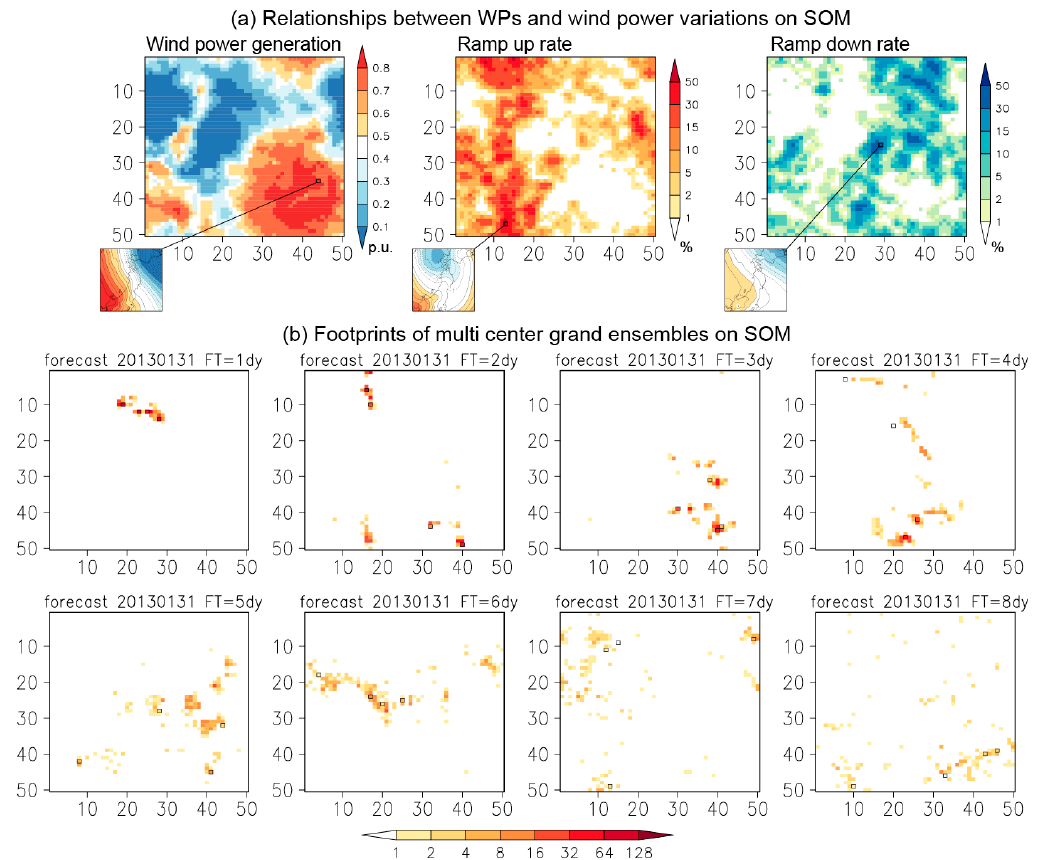
Figure 4. ( a ) The median values of wind power generation (left) and the frequency occurrence rate (%) of ramp-up (middle) and ramp-down (right) within each SOM node. Each bottom-left figure shows the correspondence with Figure 3a–c, respectively. ( b ) The SOM frequency (best-matched) of the 168 multi-center ensemble members on the 50 × 50 SOM lattice for forecast days 1–8 initiated from 1 January 2013. Solid black box represents the actual state.